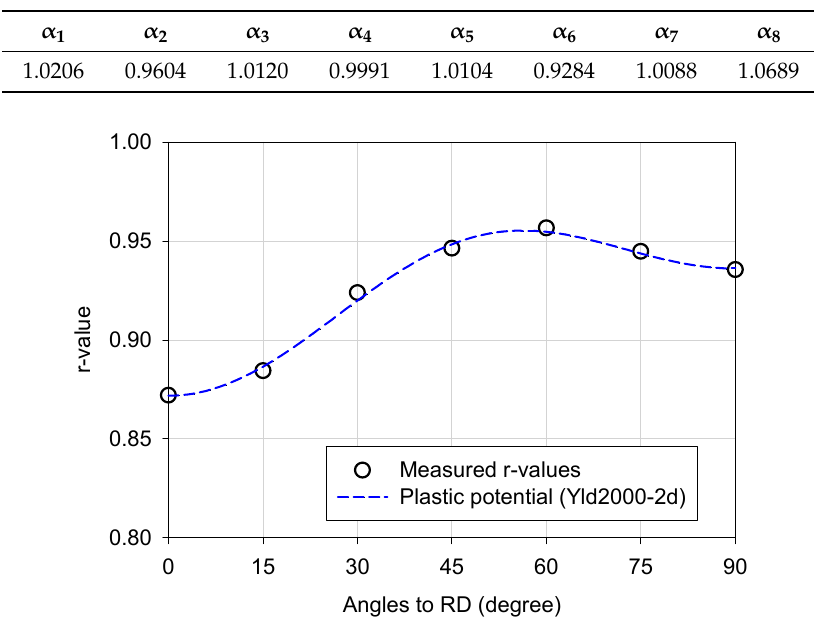
Figure 7. Comparison of the averaged r -values for the Q&P 980 steel and the calculated distribution based on the plastic potential function.